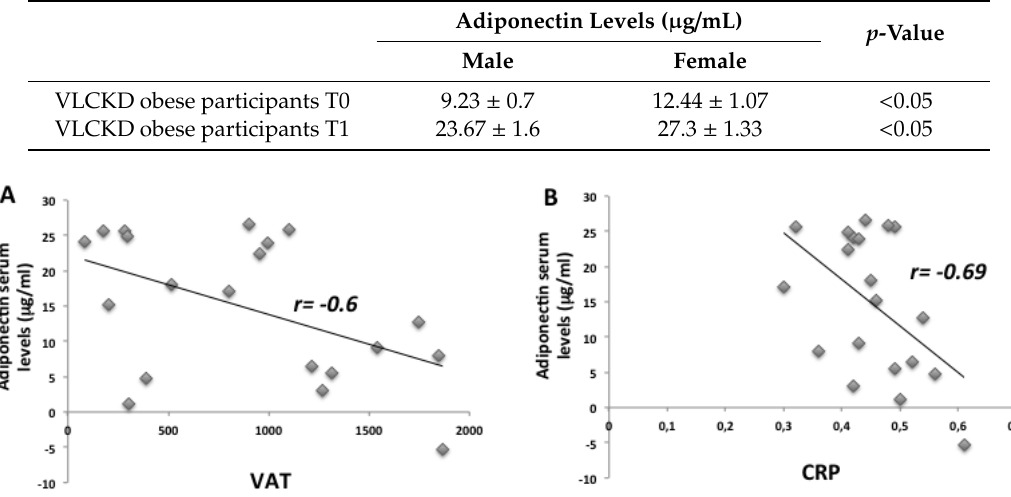
Table 2. Adiponectin serum levels in male and female VLCKD obese participants.